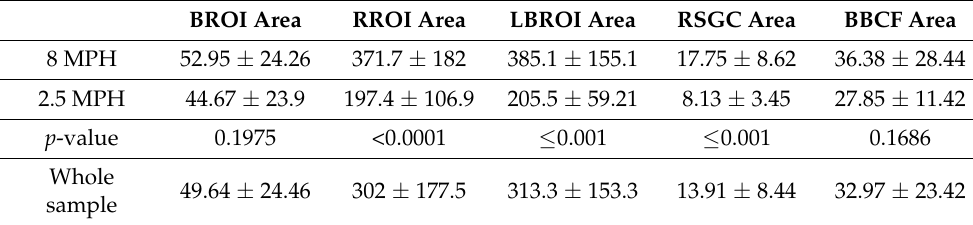
Table 2. Numerical data on X and the results of what analysis of the zones in the two groups. The value ( p < 0.05) from unpaired t -test with Welch’s